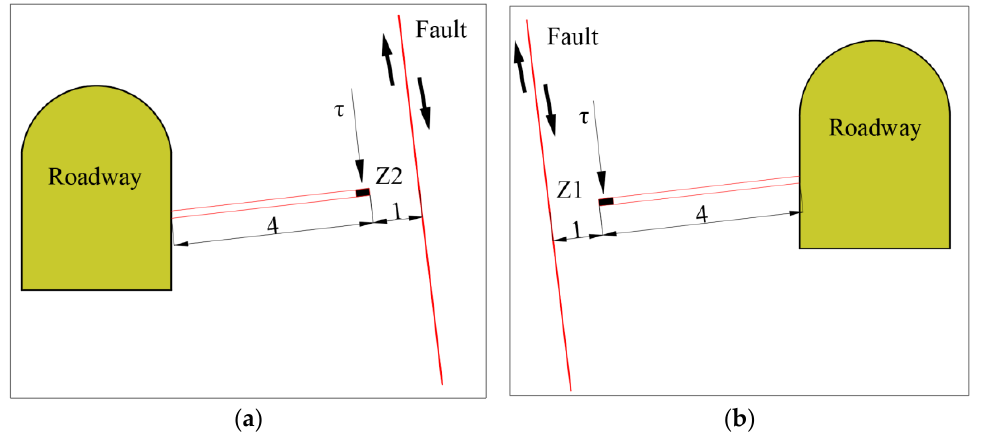
Figure 7. Installation schematic diagram of the borehole stress meter, they should be listed as: ( a ) Installation diagram of the borehole stress meter in the footwall of the fault; ( b ) Installation schematic diagram of the borehole stress meter in the hangingwall of the fault.